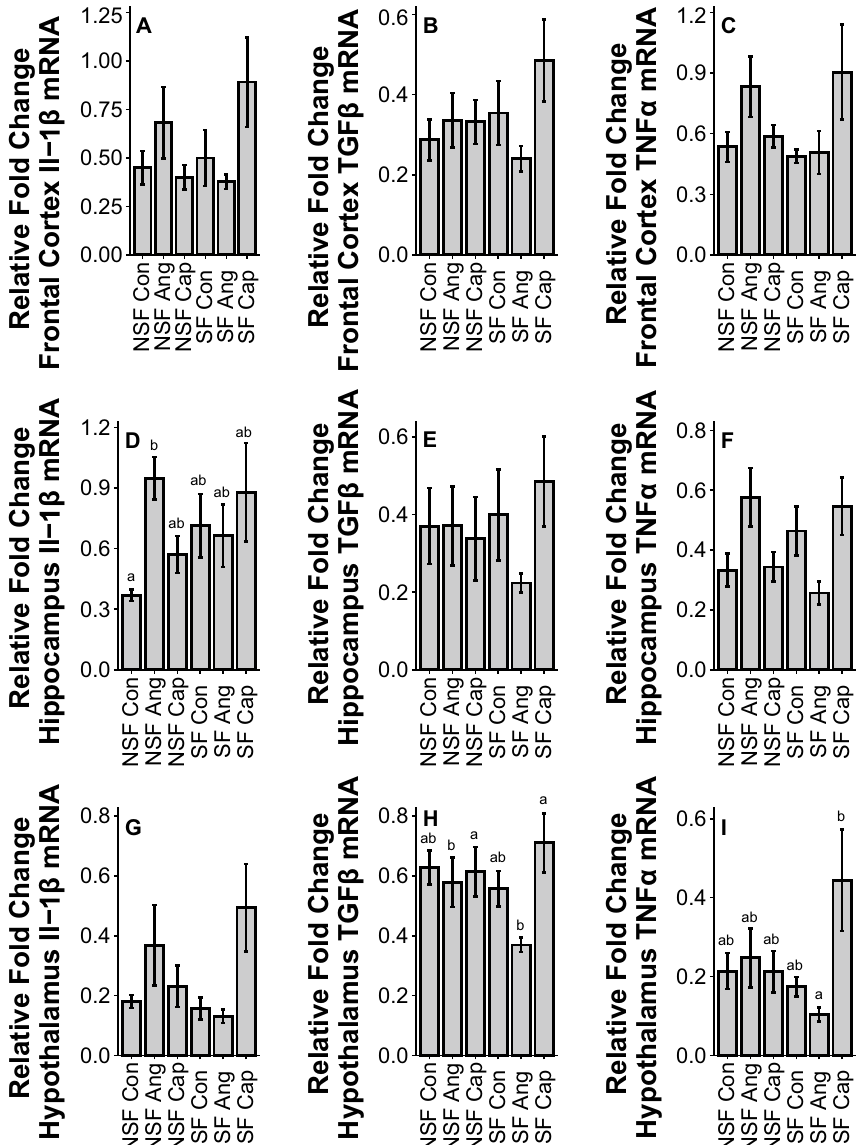
Figure 4. Effects of sleep fragmentation, RAS manipulation, and their interaction on Il-1β, TGFβ, and TNFα gene expression in brain tissues, prefrontal cortex ( A , B , C ), hippocampus ( D , E , F ), and hypothalamus ( G , H